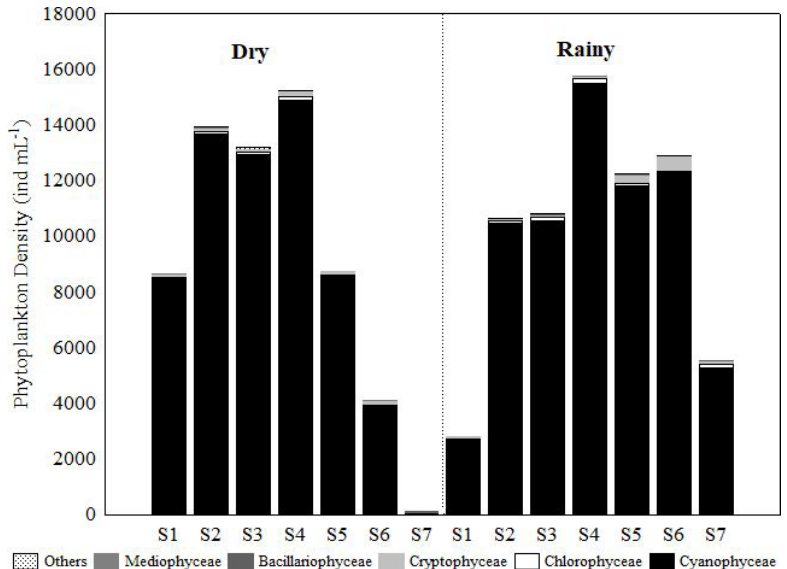
Figure 6. Spatial and temporal variation of the phytoplankton density in the João Leite reservoir, GO, Brazil during a dry and rainy